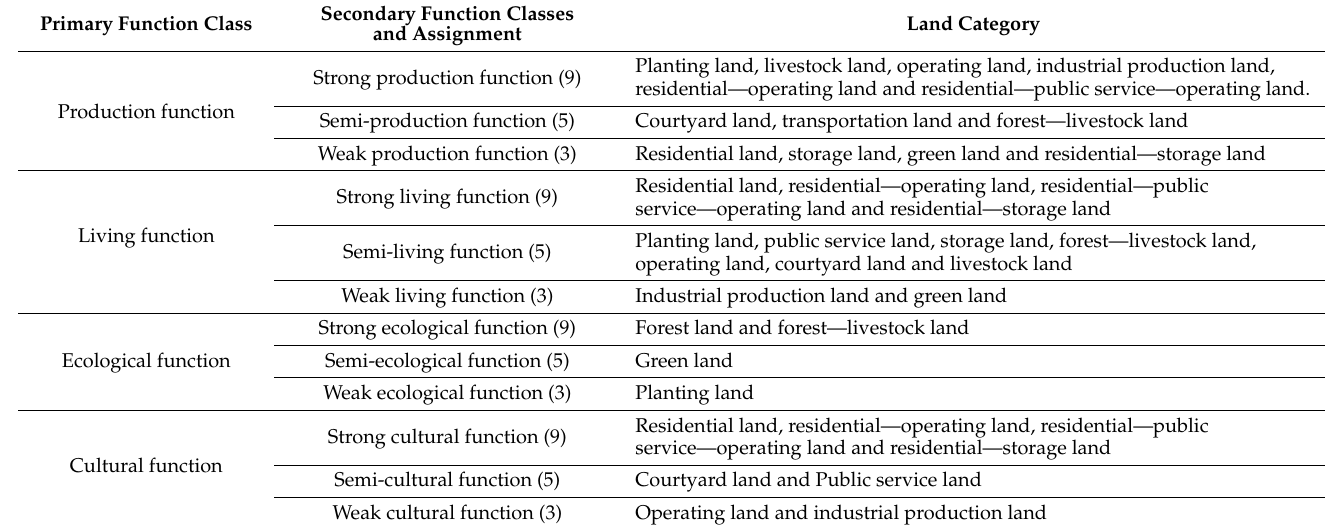
Table 4. The production–living–ecological–cultural function assignment table of rural settlement land in the study area in